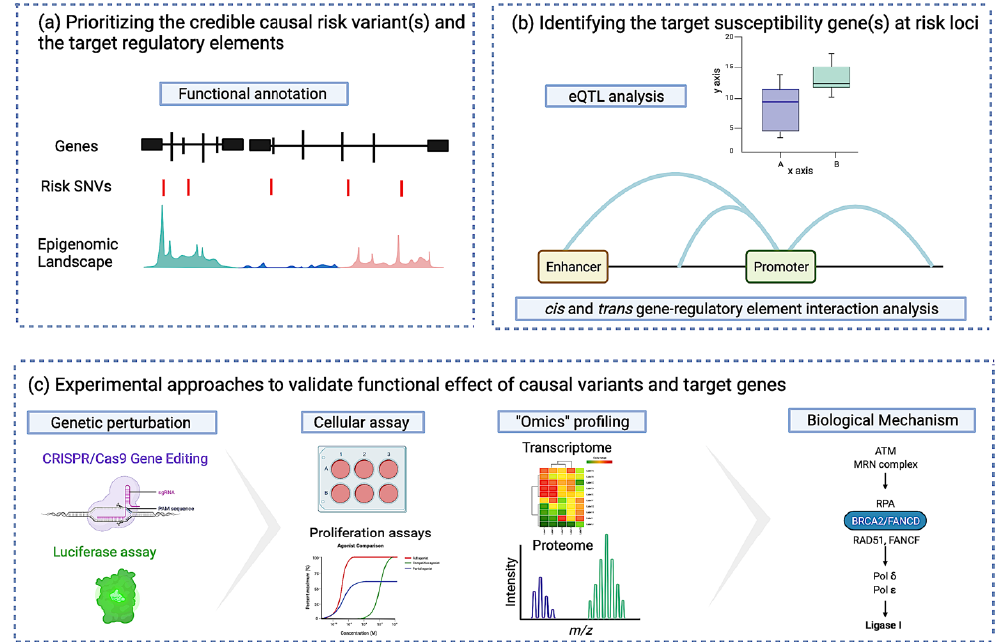
Figure 3. Illustration of functional follow-up analysis of non-coding low penetrance common risk variants. ( a ) Integration of genotype and epigenomic data to identify the candidate regulatory targets of risk variants; ( b ) Integrative analysis of the correlation between genotype to gene expression paired with gene-regulatroy element interaction, identifies putative candidate susceptibility genes; and ( c ) genome editing, multiomics, and cell biology assays are utilized to functionally evaluate noncoding DNA elements and their potential target genes to uncover their role in neoplastic development.